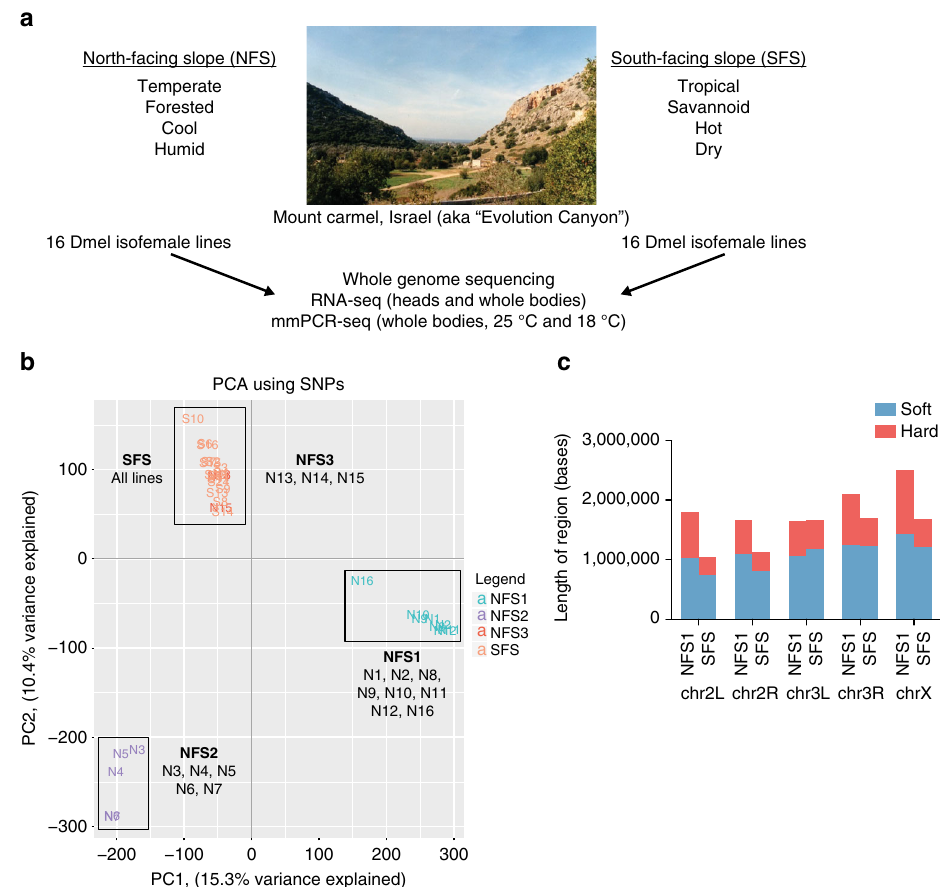
Fig. 1 Genetic differences and selective sweeps in D. melanogaster from Evolution Canyon. a Schematic detailing the sequencing experiments performed. Photo credit: Michael Margulis. b PCA plot using SNPs from the 32 Evolution Canyon fl y lines, with a single fl y represented per line. The sub-populations are labeled as follows: NFS1 (turquoise), NFS2 (purple), NFS3 (red), SFS (orange). c Bar plot showing length of hard and soft sweep regions in 4 NFS1 and 12 SFS lines for different